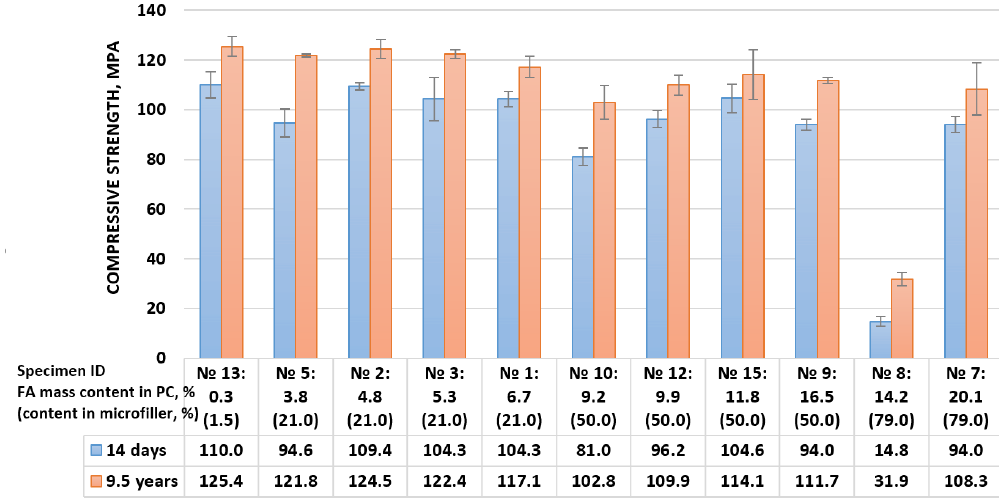
Figure 6. Compressive strength of vinyl-ester concretes of various mass contents of fly ash remaining